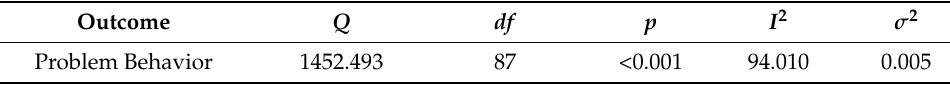
Table 2. Effect heterogeneity test results.